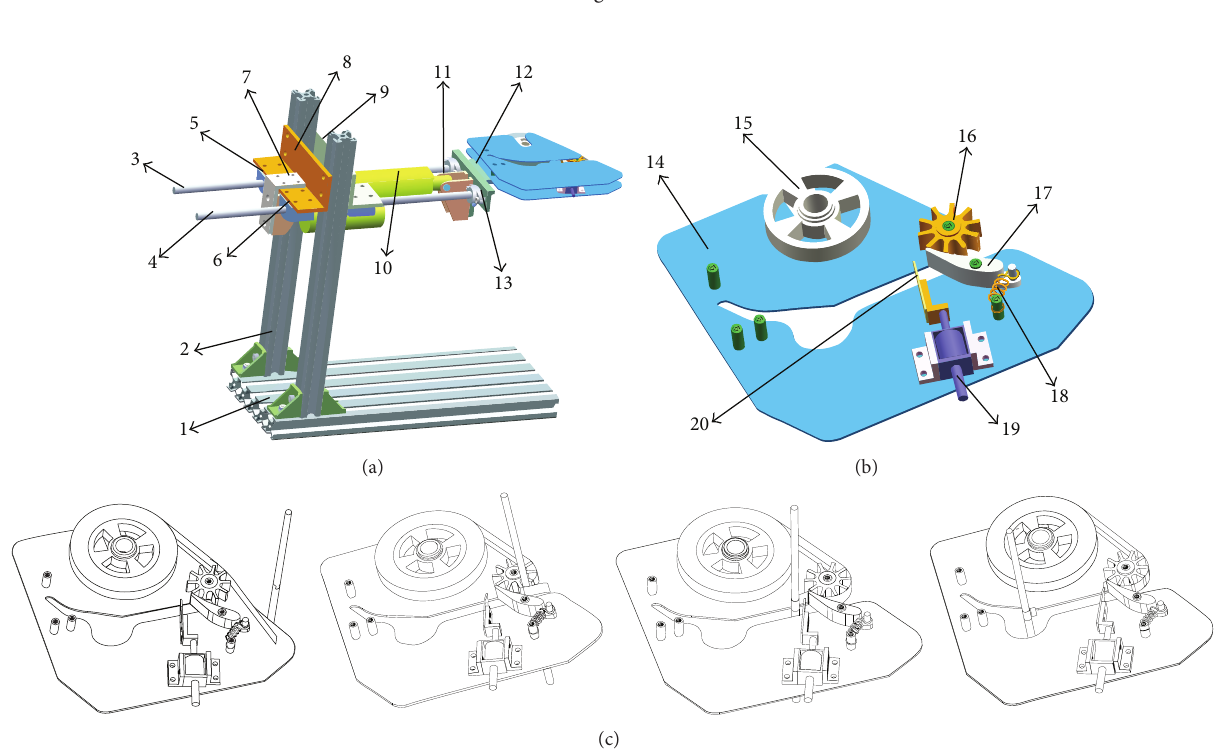
Figure 10: Structure of the binding mechanism. (a) Binding mechanism integrated diagram. (b) Internal diagram of the binding components. (c)Workingprocess.1:baseboard,2:verticalpillar,3:guidingshaftI,4:guidingshaftII,5:slidingunitI,6:slidingunitII,7:pushrodmounting base, 8: left mounting base, 9: right mounting base, 10: electrical push rod, 11: guiding shaft base I, 12: moving base, 13: guiding shaft base